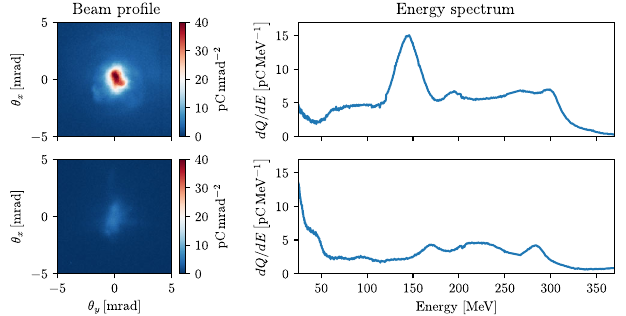
(2014).FIG. 5. Beam profile and energy spectra of representative shots with only the first gas jet (top) and with tape and second gas jet